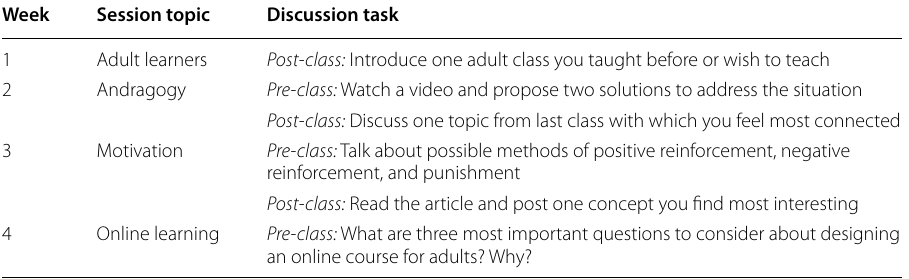
Table 2 Session topics of the first four weeks and six discussion